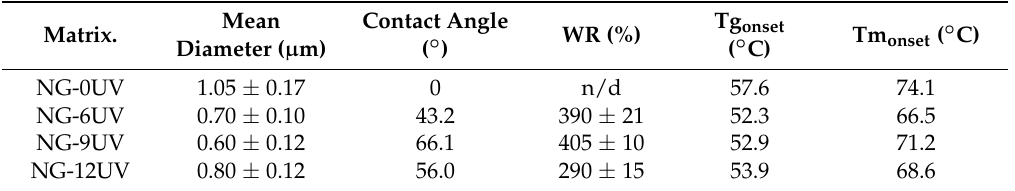
Table 1. Fiber diameter, contact angle, water uptake (WR), and DSC results, melting temperature (Tm), and the onset of glass transition temperature (Tg), of GelMA mats.